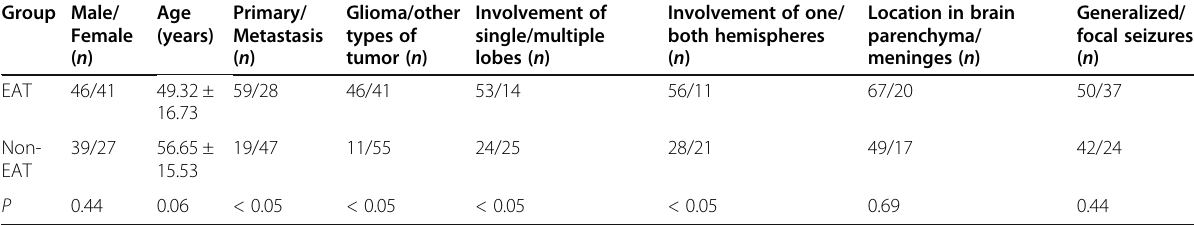
Table 5 Comparisons between EAT and non-EAT groups Group Male/ Female